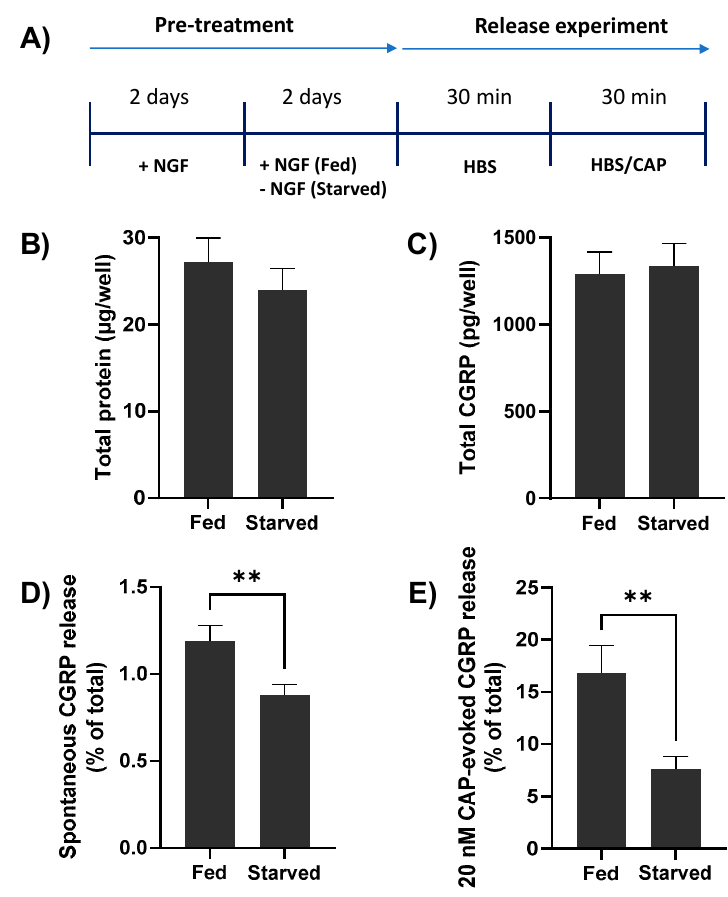
Figure 2. Deprival of NGF for 2 days does not significantly alter total protein or calcitonin gene- related peptide (CGRP) contents of rat cultured TGNs but reduces both spontaneous and CAP-evoked exocytosis of the neuropeptide. ( A ) Schematic illustrating the experimental protocol. Rat TGNs were cultivated initially in the presence of NGF (50 ng/mL) for 2 days before its withdrawal from half of the wells (starved) or retention for the other cohort over the 4 days (fed). The amounts of CGRP released were quantified during sequential 30 min. exposures, firstly to HEPES buffered saline (HBS) only (( D ), spontaneous release), and then to 20 nM CAP in HBS ( E ). At the end of experiments, cells were solubilised with 1% ( v / v ) Triton X-100 in HBS, then total protein ( B ) and CGRP contents ( C ) were determined, as detailed in Materials and Methods. Data are presented as mean + s.e.m., n ≥ 12, N = 3. Asterisks summarise the results of unpaired t -tests with Welch’s correction, ** p < 0.01, shown only for significant differences.